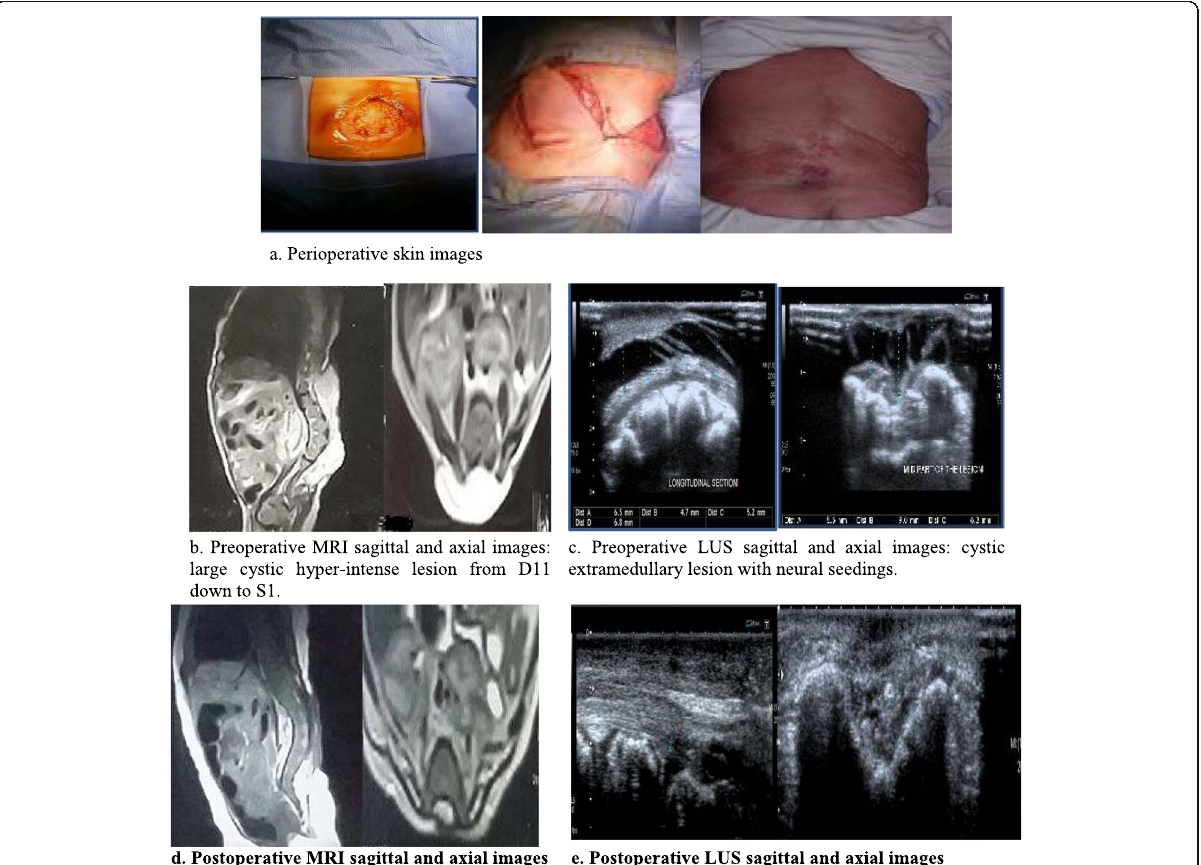
Fig. 1 Large, defined extramedullary cystic lesion about 1.3 × 3.2 × 12 cm seen opposite D11 down to S1 vertebrae with neural element component seen within the cyst and lower dorsal scoliosis. a Perioperative skin images. b Preoperative MRI sagittal and axial images: large cystic hyper-intense lesion from D11 down to S1. c Preoperative LUS sagittal and axial images: cystic extramedullary lesion with neural seedings.